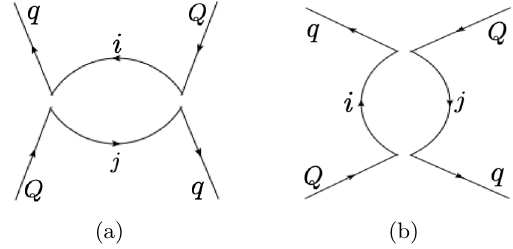
¯ d ) . i and j denote down-